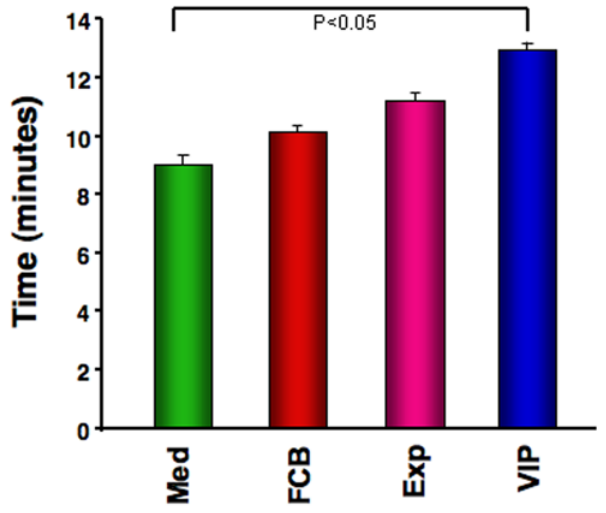
Figure 4. Measurement of exercise capacity. Exercise capacity was evaluated by time on a graded treadmill after six weeks of therapy demonstrated an incremental time in the order of VIP . Exp . FCB . Med